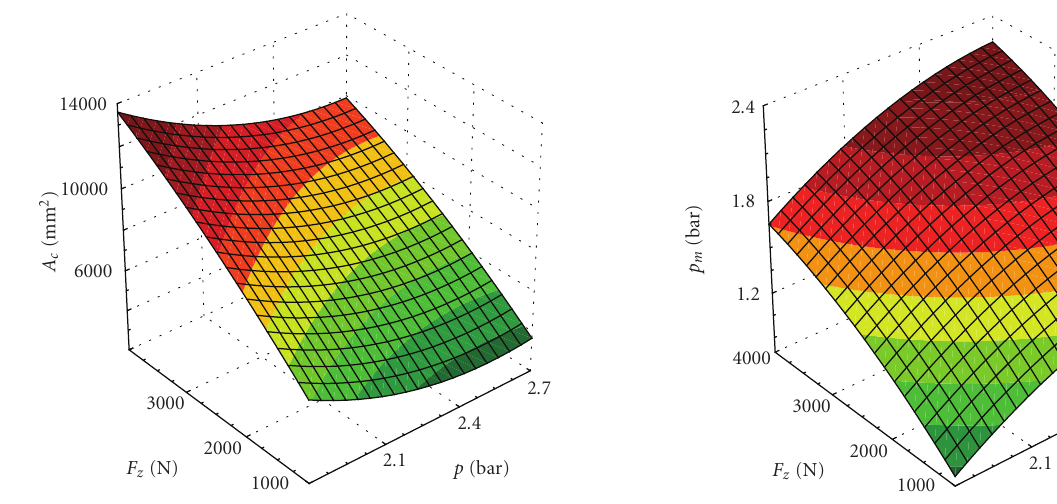
Figure 8: Average contour pressure for Tire 2 as a function of pressure and vertical load.